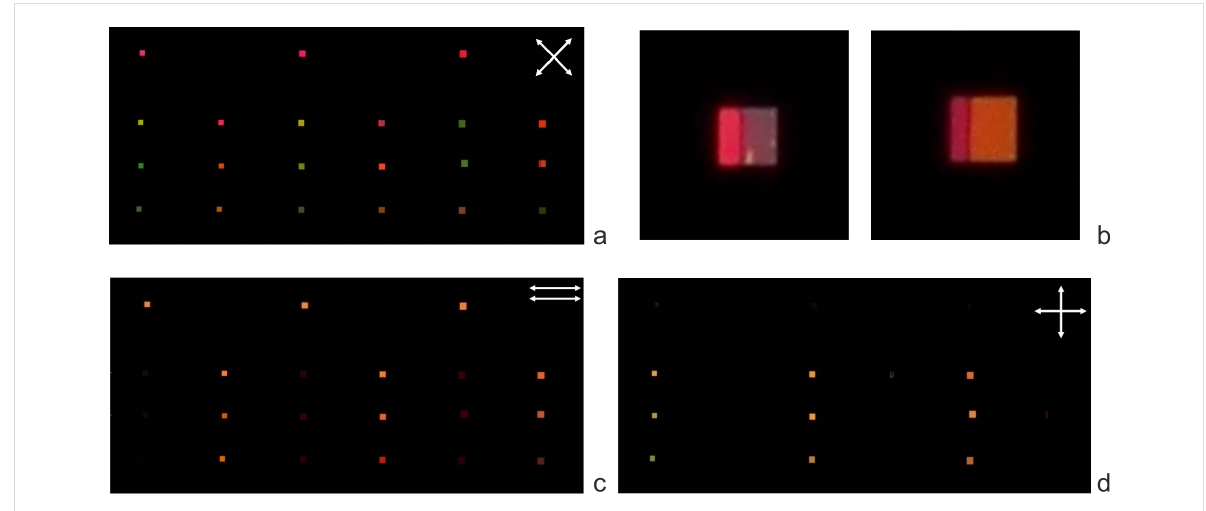
Figure 3: Photos of the liquid crystal cell under polarized light: (a) , the sample axis (rubbing direction) is at 45° to P1 and P2; (b) the enlarged part of photo a, showing two gratings: p = 350 nm, w / p = 2/3 (left) and p = 400 nm, w / p = 1/2; (c) P1 P2, the sample axis is at 90° to the input po- larization P1; (d) , the sample axis is at 90° to the input polarization